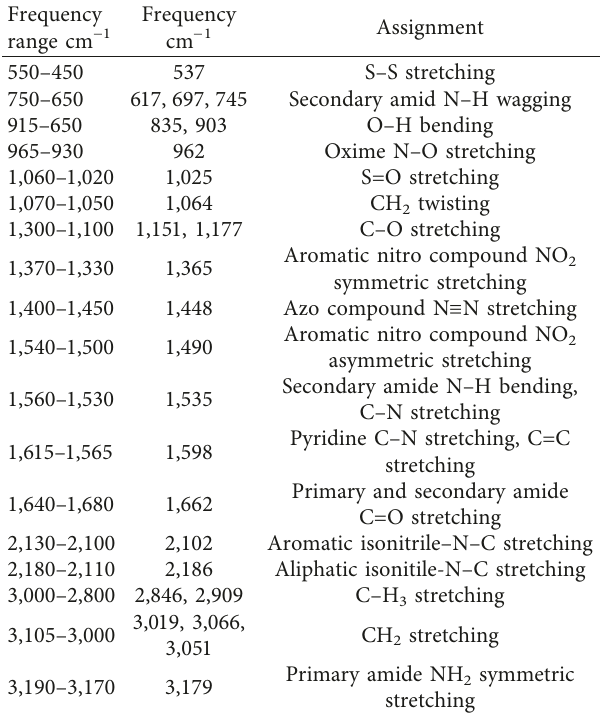
Table 6: The main FT-IR function group composition of biocrude from HTL of Spirulina sp.